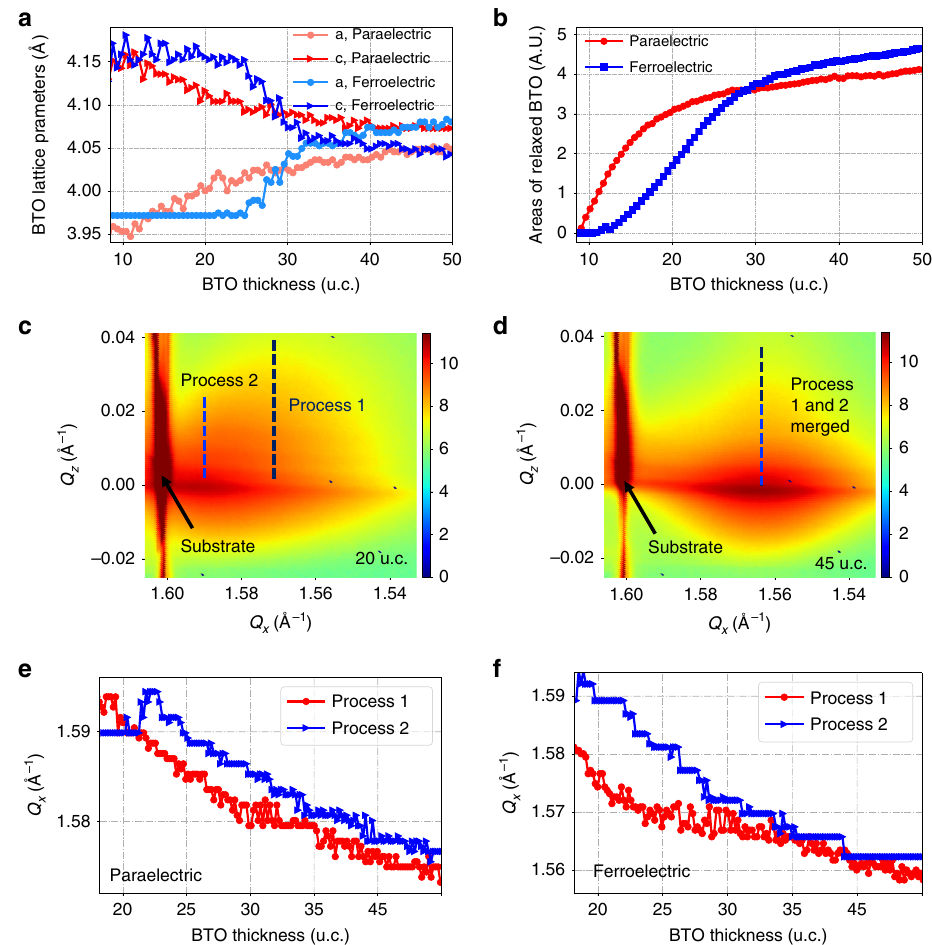
Fig. 6 Relaxation process. a – b Relaxation process: a In-plane and out-of-plane lattice parameters of relaxed BTO plotted against BTO growth time for two samples: one grown on paraelectric PTO (3 u.c. PTO, 565 °C, red and light red represent lattice parameters c and a , respectively), and another grown on ferroelectric PTO with largest polarization among all samples (4 u.c. PTO, 500 °C, blue and light blue represent lattice parameters c and a , respectively). b Areas of the relaxed part of BTO fi lm plotted against BTO growth time for two samples described in a : red grown on paraelectric PTO and blue grown on ferroelectric PTO. c , d Examples of reciprocal space maps obtained by in situ grazing incidence diffraction in the vicinity of the (1 0 0) substrate peak (seen on the left hand side of the map at Q x ~ 1.60) for BTO fi lms grown on six layers of PTO fi lms at 565 °C after a 20 u.c. layers and b 45 u.c. layers BTO were grown. Two types of relaxation process were seen, which begin at different Q x positions in the beginning of growth and merge to the same Q x positions at the end of the growth. e , f Evolution of the Q x positions of the two relaxation features plotted against BTO thickness for two samples: one grown on paraelectric PTO ( c 3 u.c. PTO, 580 °C), and another grown on ferroelectric PTO with largest polarization among all samples ( d 3 u.c. PTO, 500 °C). Red and blue data represent Process 1 and Process 2, respectively. Source data are provided as a Source Data fi